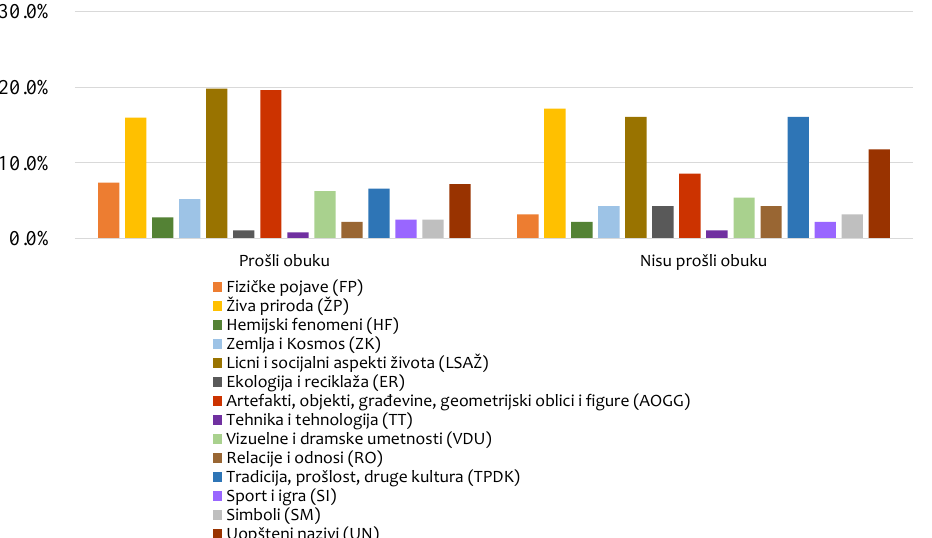
30.0% 0.0%10.0%20.0%